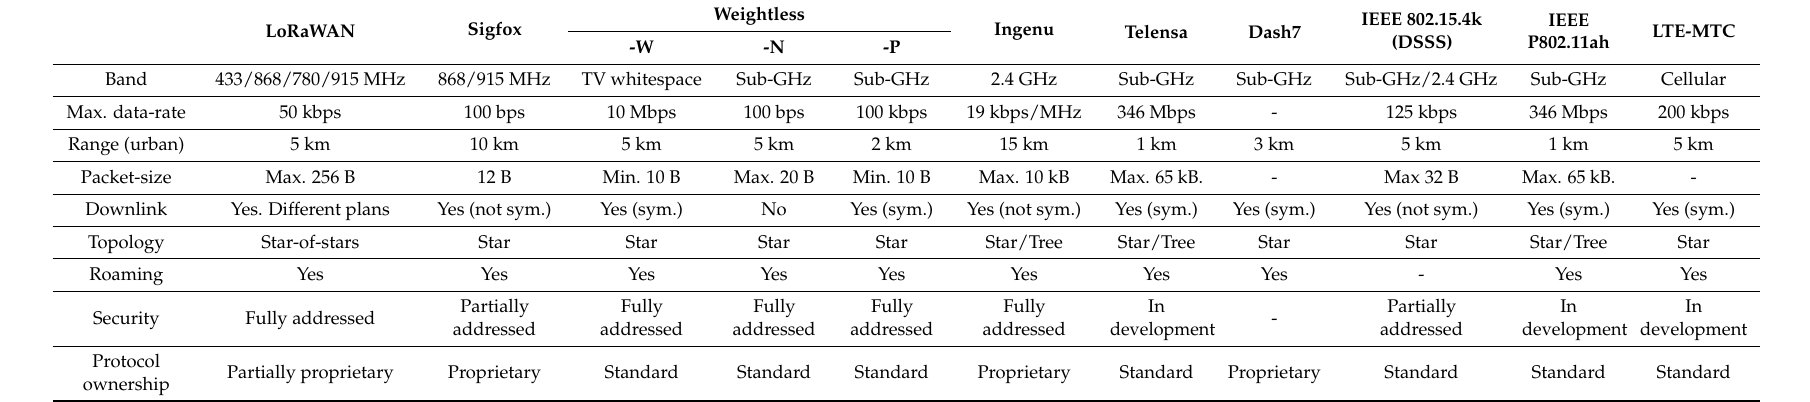
Table 1. LP-WAN platforms